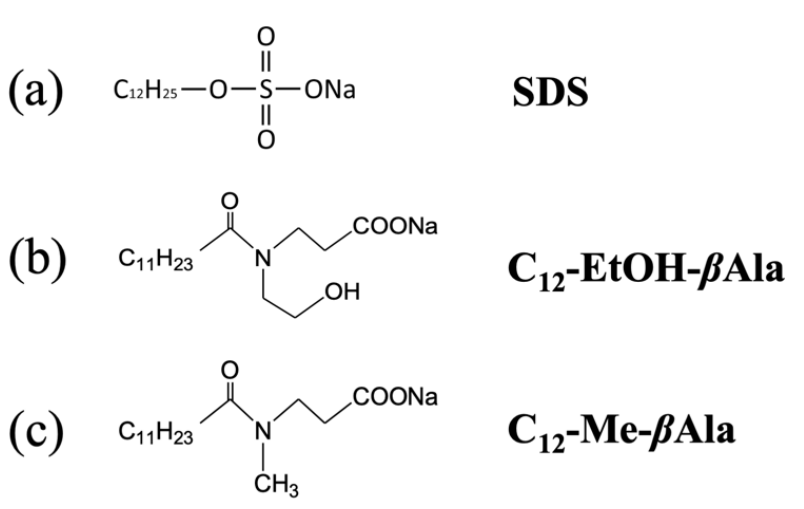
Figure 4. Chemical structures of ( a ) sodium dodecyl sulfate (SDS), ( b ) N – dodecanoyl – N – (2-hydrox- yethyl) – β – alanine (C 12 – EtOH – β Ala), and ( c ) N – dodecanoyl – N -methyl – β – alanine (C 12 – Me – β